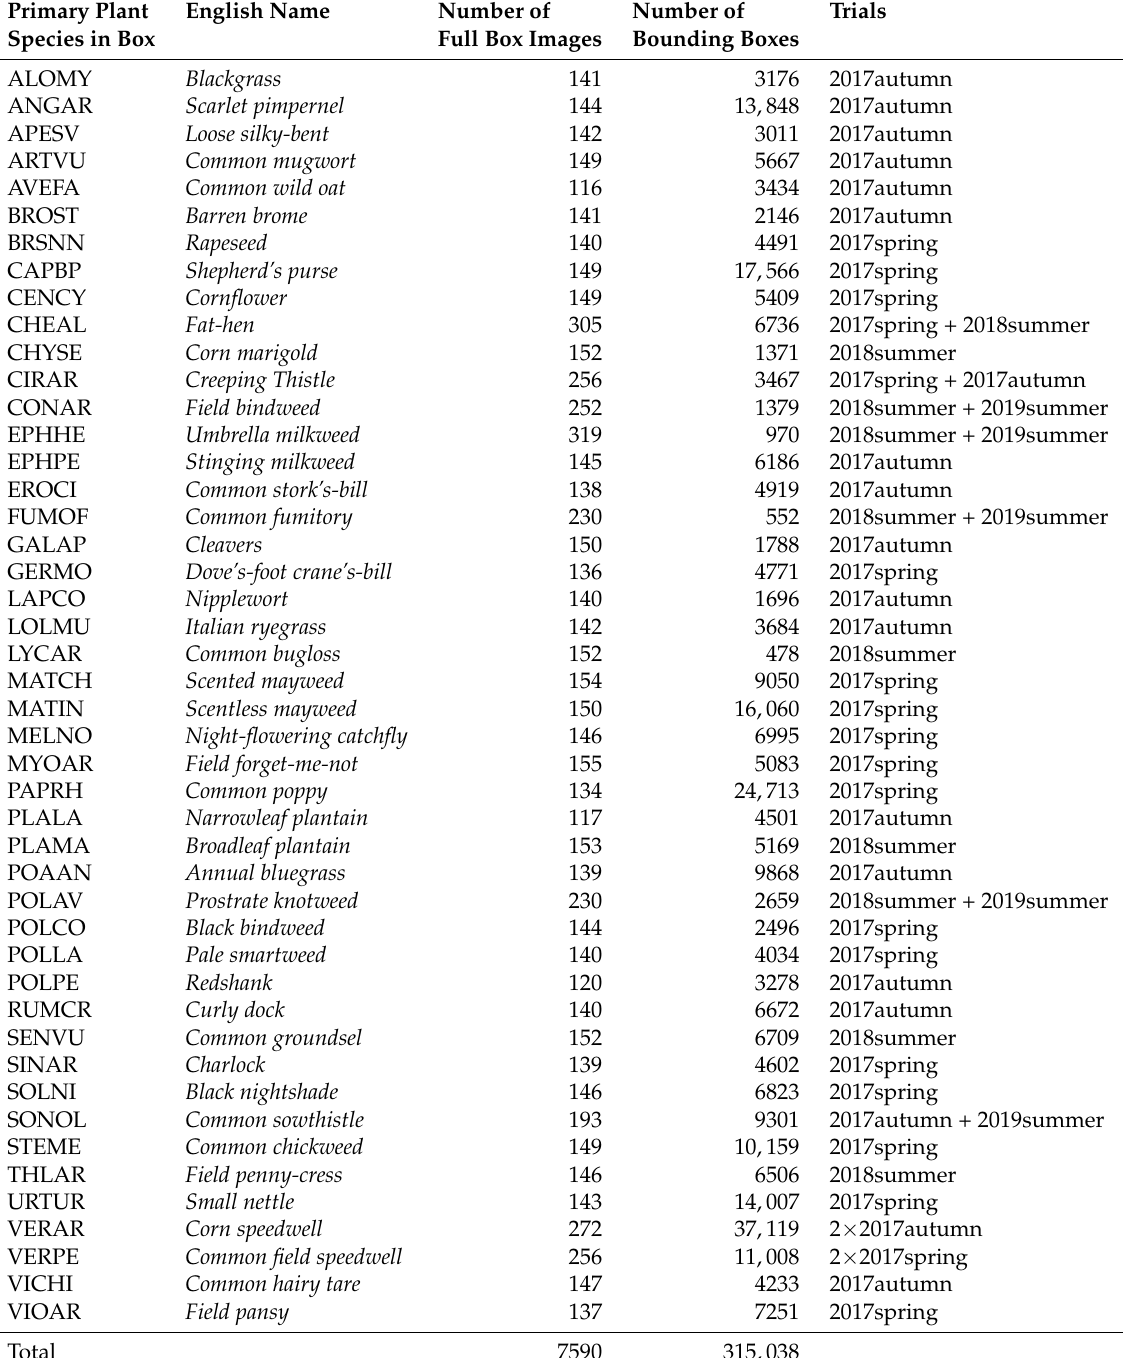
Table A1. Database content. Number of full box images and bounding boxes for each of the sown/primary species in the dataset. Note some species are cultivated in multiple trial seasons or twice in a single season, to increase germination